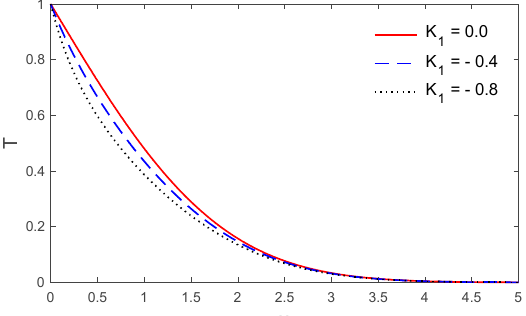
Figure 1. Variations of temperature with respect to the distance for various values of K 1 .